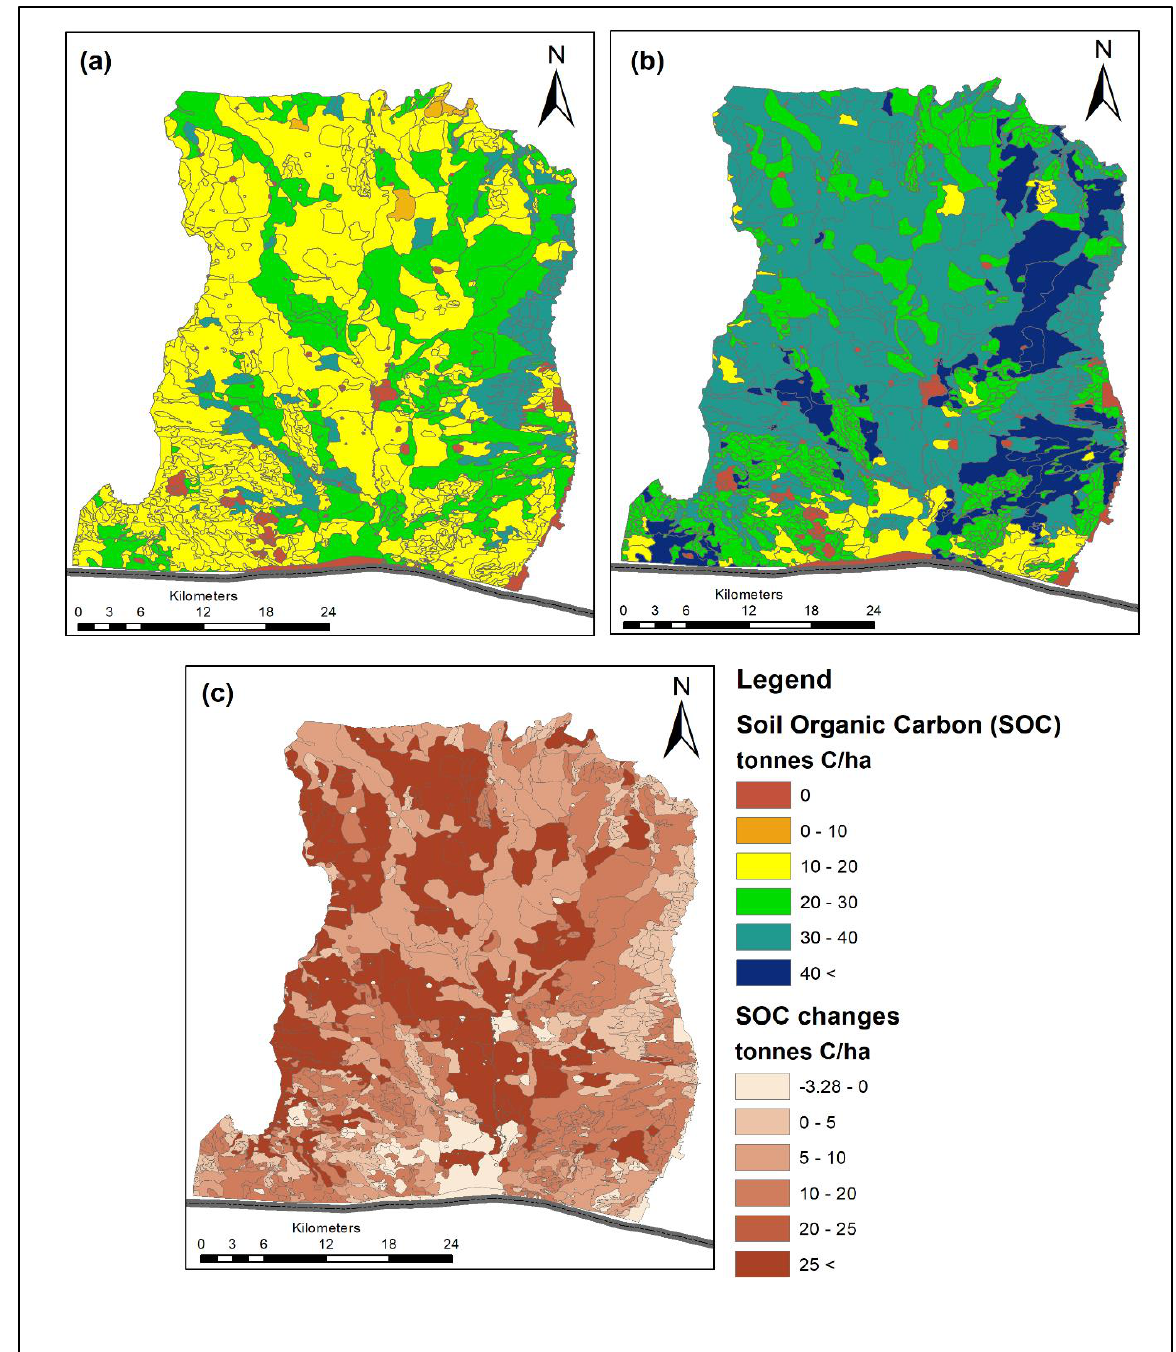
Figure 5. (a) SOC in 1988, (b) SOC in 2017; and (c) SOC changes between 1988 and